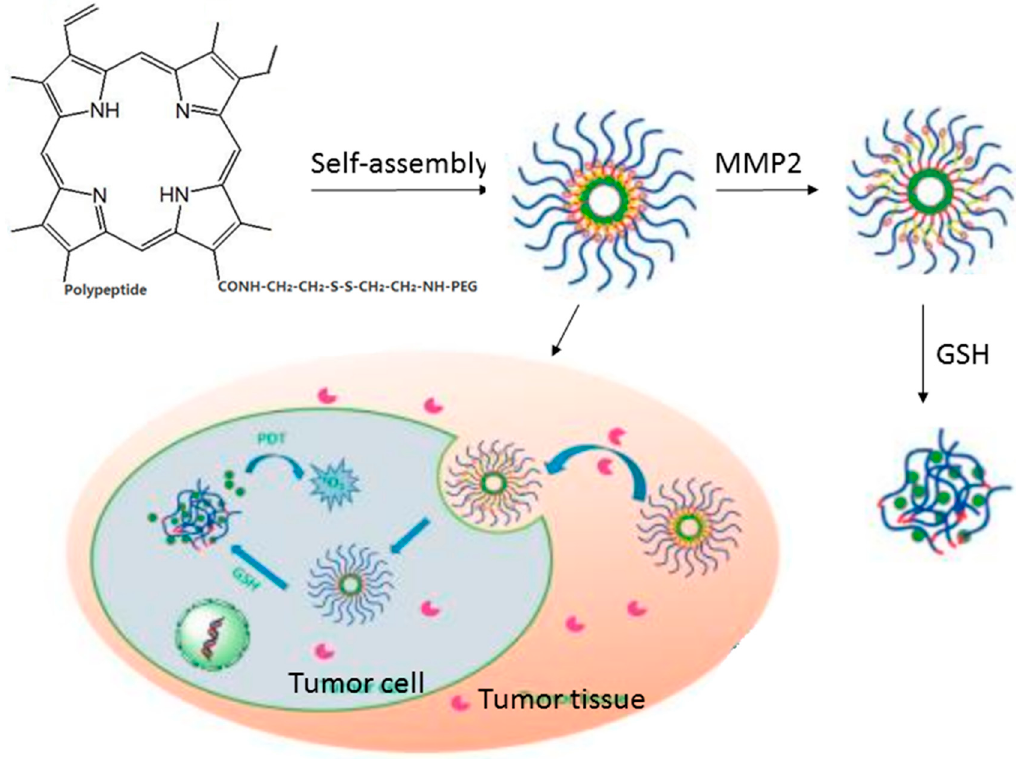
Figure 3. Schematic illustration of the preparation of the PEG-SS-Ce6-MMP2 NPs and Their applications in vivo. Copyright (2016) American Chemical Society [52].